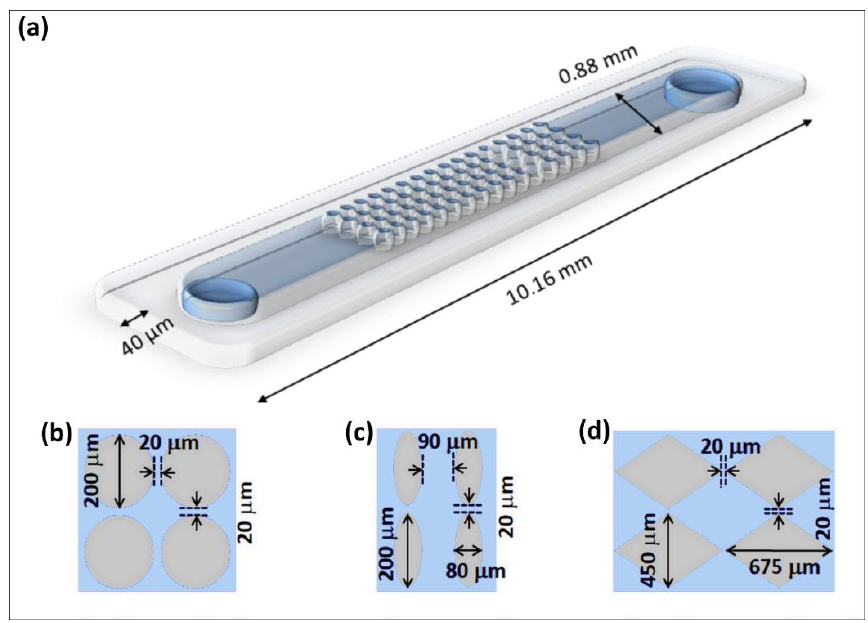
Figure 1. ( a ) Schematic representation of a microfluidic channel with post array. ( b ) Close-up of circle-shaped posts, ( c ) oval-shaped posts and ( d ) diamond-shaped posts.